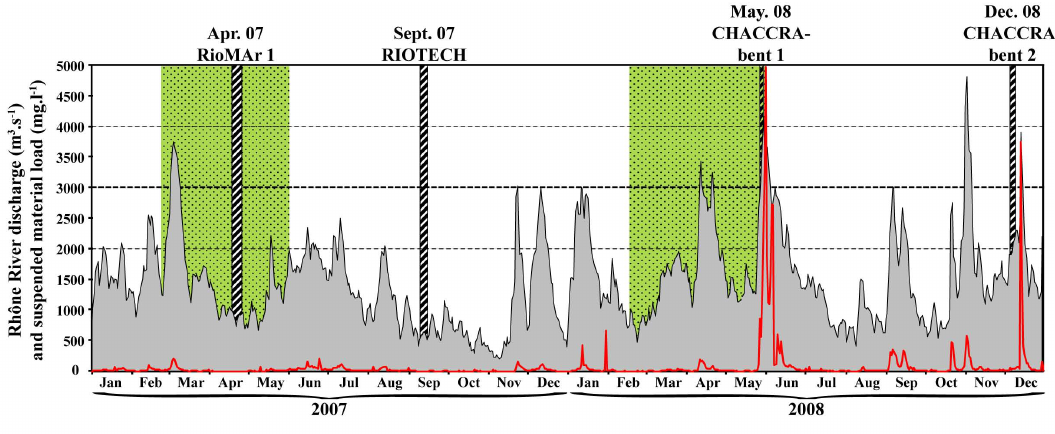
Fig. 2. Mean daily discharge (light-grey area) and suspended particulate material load (red curve) of the Rhˆone River recorded by the Compagnie Nationale du Rhˆone and the IRSN at SORA station (Arles), located ∼ 30km upstream from the river mouth from January 2007 to December 2008. Different sampling campaigns are represented by black-dashed areas; green dotted areas represent spring blooms in the Gulf of Lions (SeaWIFS